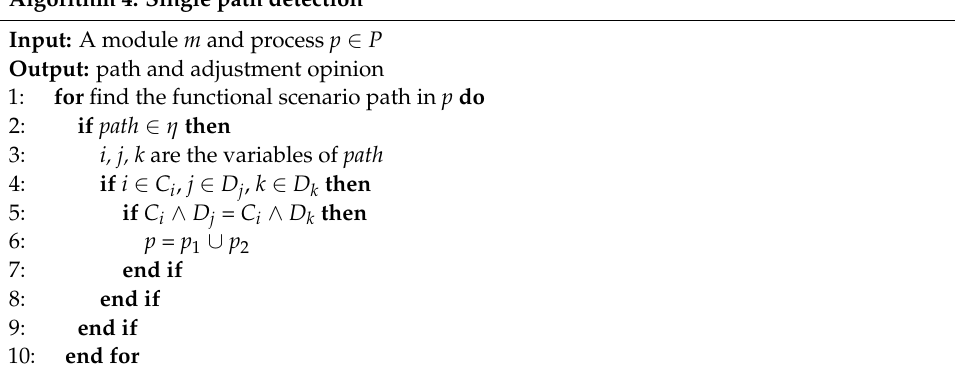
Algorithm 4: Single path